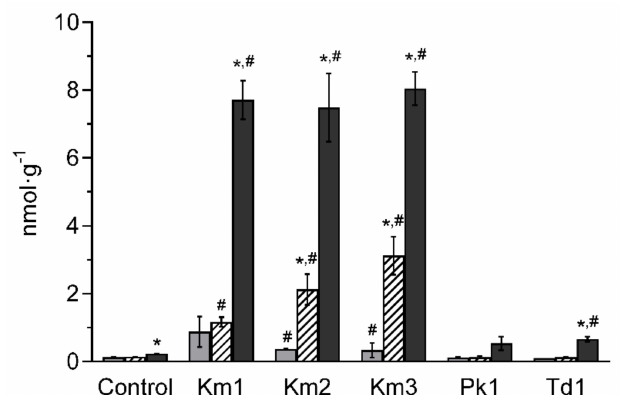
Figure 6. Production of carbon dioxide (CO 2 , nmol · g − 1 ) by yeasts K. marxianus (strains Km1, Km2 and Km3), P. kudriavzevii Pk1 and T. delbrueckii Td1 in skyr, and in controls (without addition of yeasts) after 7 days (grey columns), 14 days (white columns) and 21 days (black columns) incubation at 8 ◦ C. Mean values and SD (bars) from triplicate experiments are presented. Hashes denote significant differences between yeasts and controls within the same day of incubation, and asterisks indicate significant differences across the time points determined by the Student’s t -test ( p <